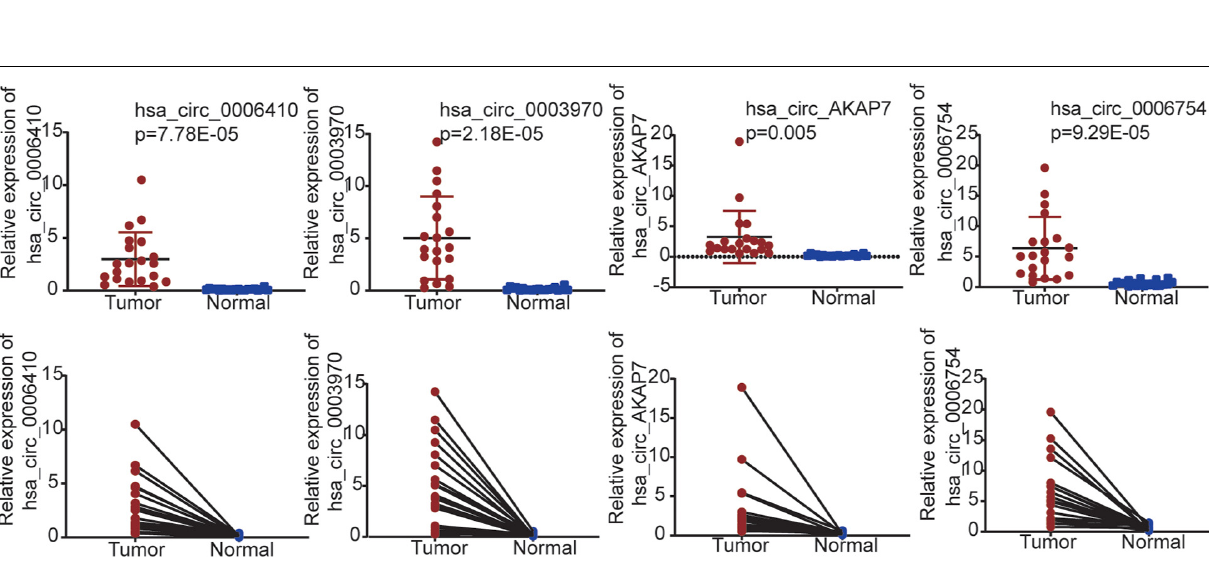
FIGURE 5 | Survival analysis of the five circRNA cognate genes in PCa. Among these, TUSC3, AKAP7, and RBM39 were significantly related with survival probability. The red line represents high gene expression, and the blue line represents low gene expression.